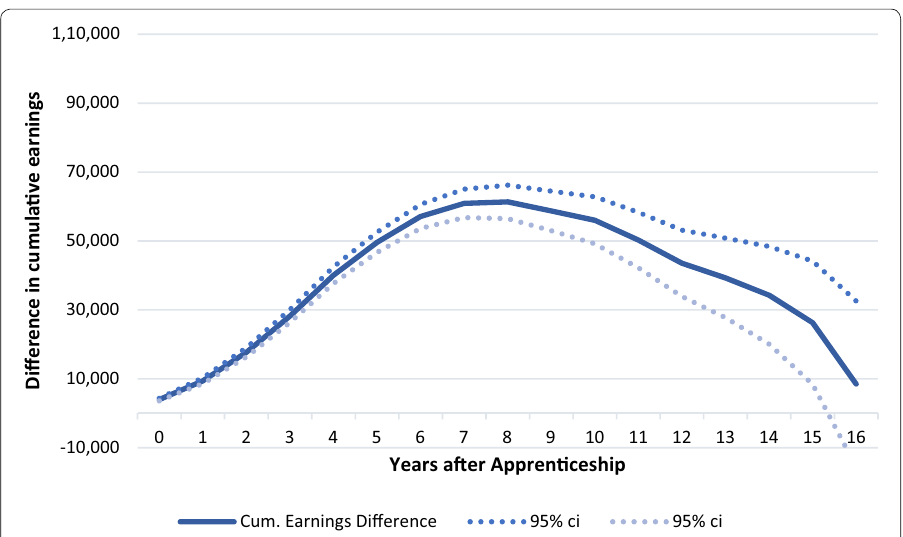
Fig. 6 Differences in cumulative earnings between foremen and academics after completed apprenticeship before matching (2213 foremen and 17,062 academics)